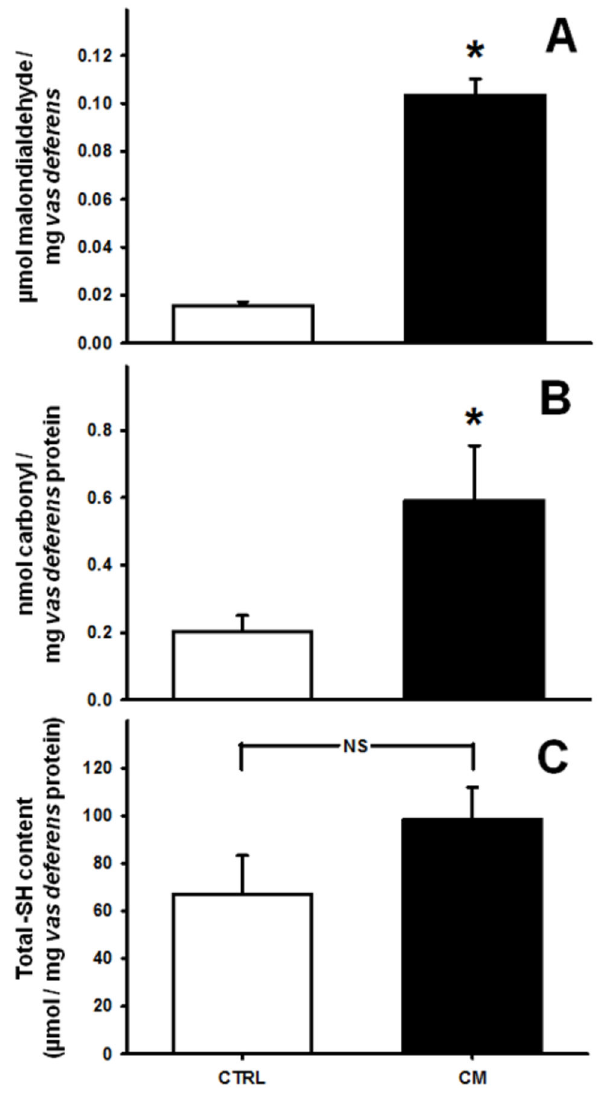
Figure 4. Oxidative damage caused by chronic malnutrition in vas deferens tissue. Levels of lipid peroxidation (A), protein carbonylation (B) and total free sulphydryl group content (C) in the vas deferens tissue cells of CTRL (empty bars) and CM (black bars) groups. Results are expressed as mean ± SEM. (A) and (C) were determined using three animals from each group; in (B), six rats from each group were used for determinations. *P<0.05 vs. CTRL. NS: no statistical difference. doi: